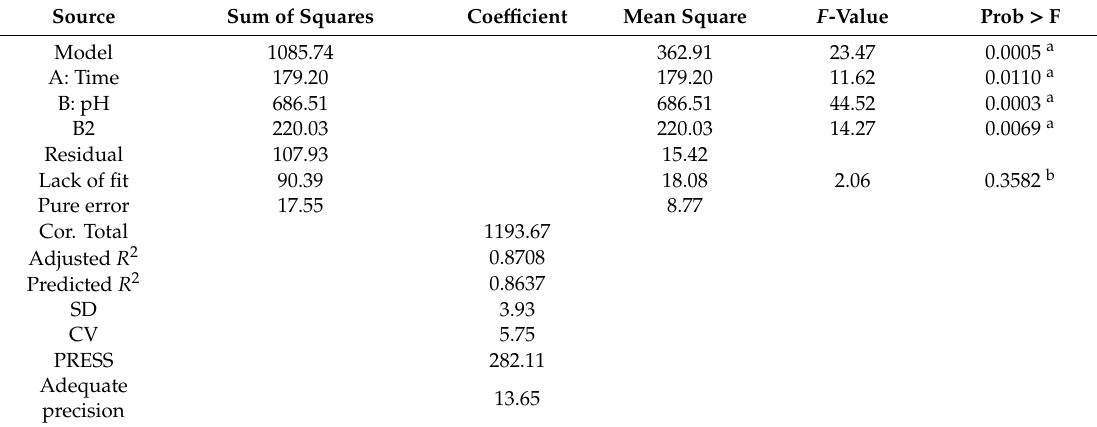
Table 4. ANOVA of independent variables for optimisation of protein precipitation from A.